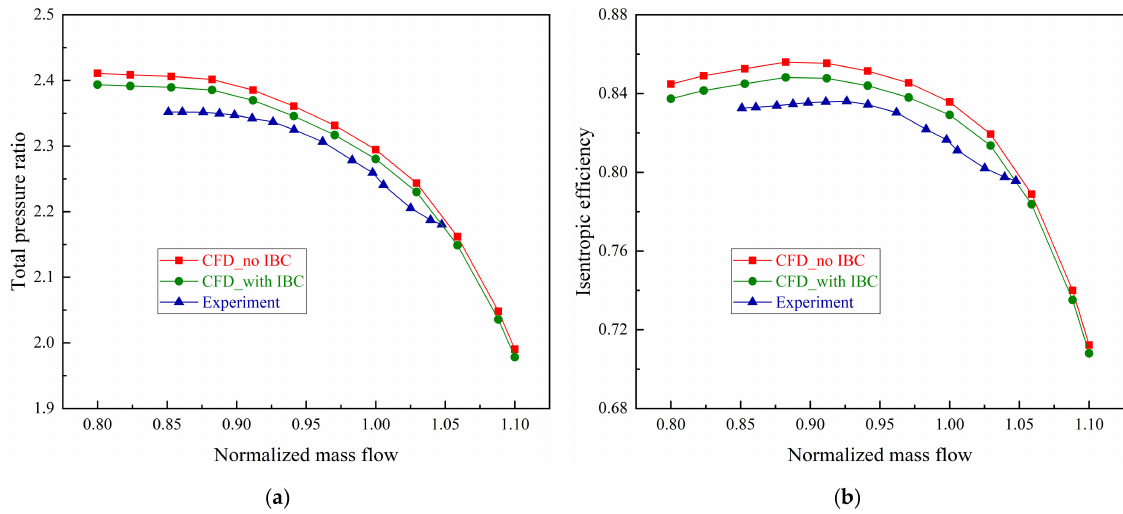
Figure 4. Predicted and measured aerodynamic performance parameters under design rotating speed: ( a ) total pressure ratio; ( b ) isentropic